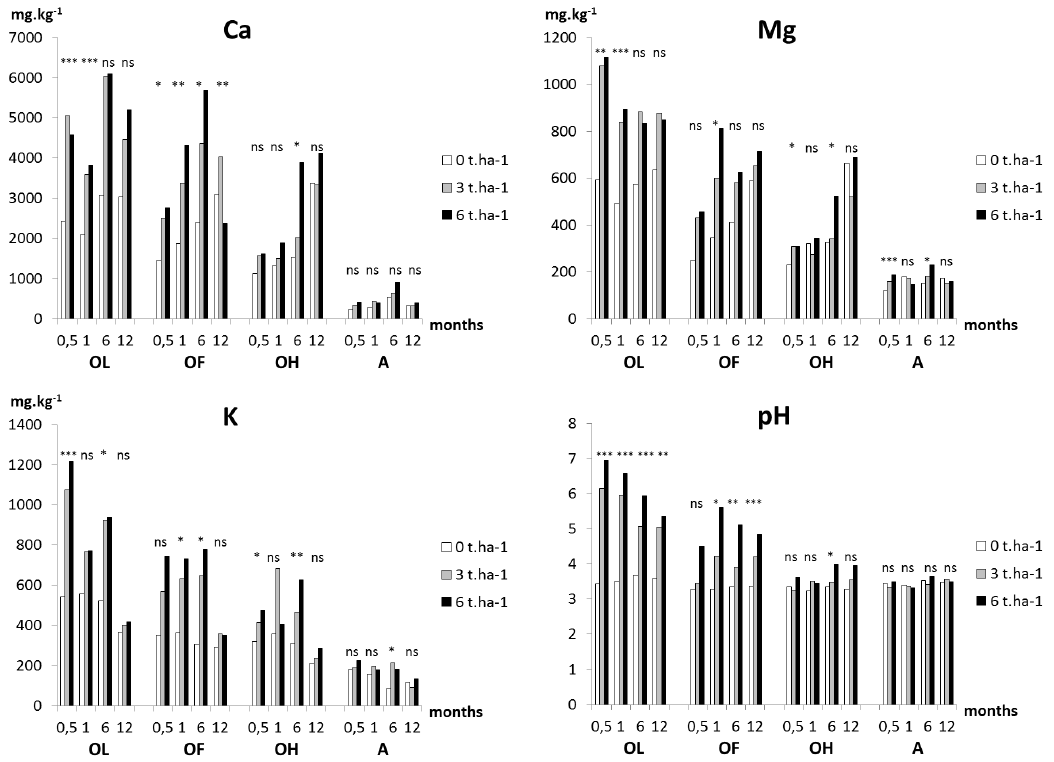
Figure 1. Comparisons of base concentration and soil acidity under different wood ash (WA) treatments. Significances of F -tests of one-way ANOVAs by horizons and sampling dates are shown (*** p < 0.001, ** p < 0.01, * p < 0.05, ns p ≥ 0.05). OL: Litter horizon; OF: Fragmented horizon; OH: